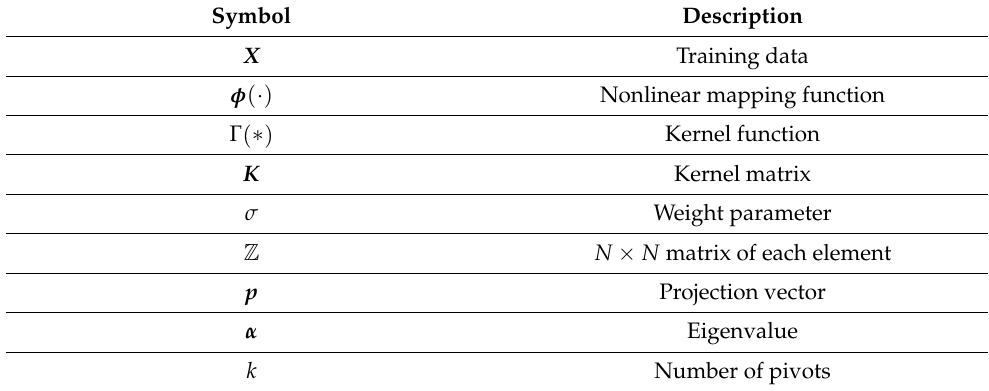
Table 1. Acronyms and notations used in the present